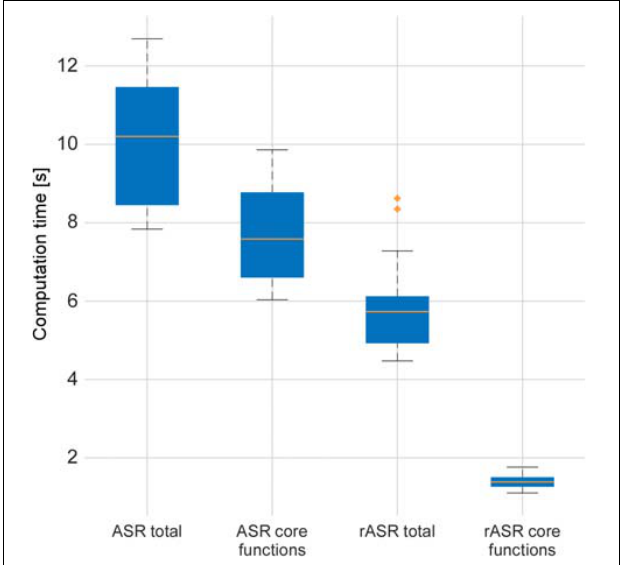
FIGURE 4 | Similarity values ( R 2 ) of eye-blink topographies obtained by correlating uncorrected and corrected topographies. A low R 2 value reflects very little residual topographical influence of blinks, thereby indicating better artifact suppression. Comparison of correlation values between uncorrected and ASR-corrected topographies ( x -axis) and between uncorrected and rASR-corrected topographies ( y -axis). The diagonal line marks the border between favorable values for rASR (lower section) and favorable values for ASR (upper section). rASR showed lower similarity values than ASR.